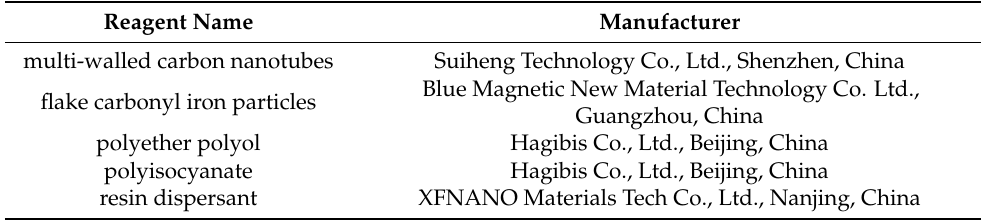
Table 2. Preparation of the required chemical reagents and materials.